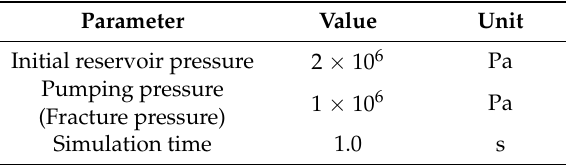
Table 2. Some parameters in simulations for Case 1.